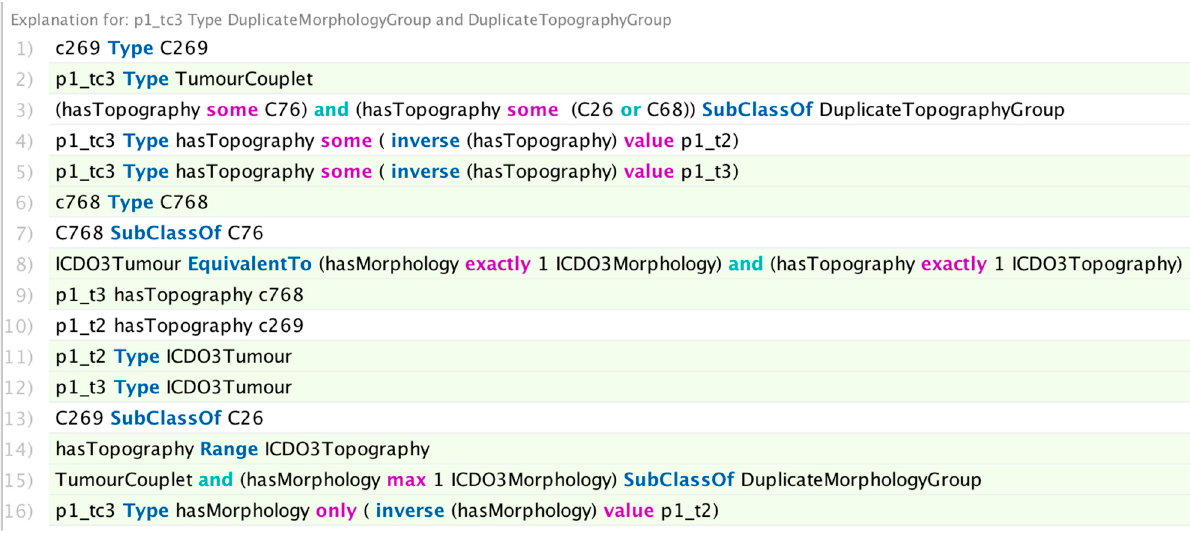
Figure 16. Explanation behind one of the results (p1_tc3) in Figure 15.